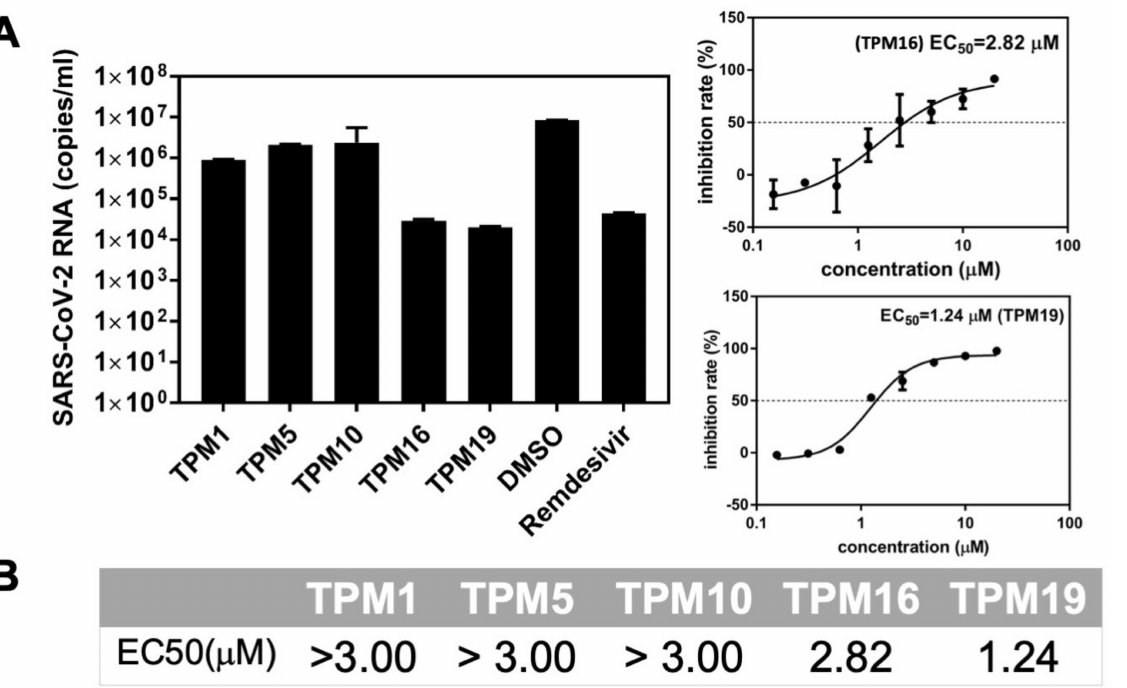
Figure 7. Anti-SARS-CoV-2 activity of the TPMs. ( A ) Left: The viral inhibitory activities were measured in Vero E6 cells at a final concentration of 10 µ M. The cells were pre-treated with indicated compounds for 2 h, infected with SARS-CoV-2, and incubated for 2 days before the total RNA was isolated from cell lysates. The viral RNA content was analyzed with qPCR. DMSO was used as the vehicle control, and remdesivir was used as the positive control. Right: representative measurement of EC 50 for the TPM ligands. ( B ) Summary of EC 50 on Vero E6